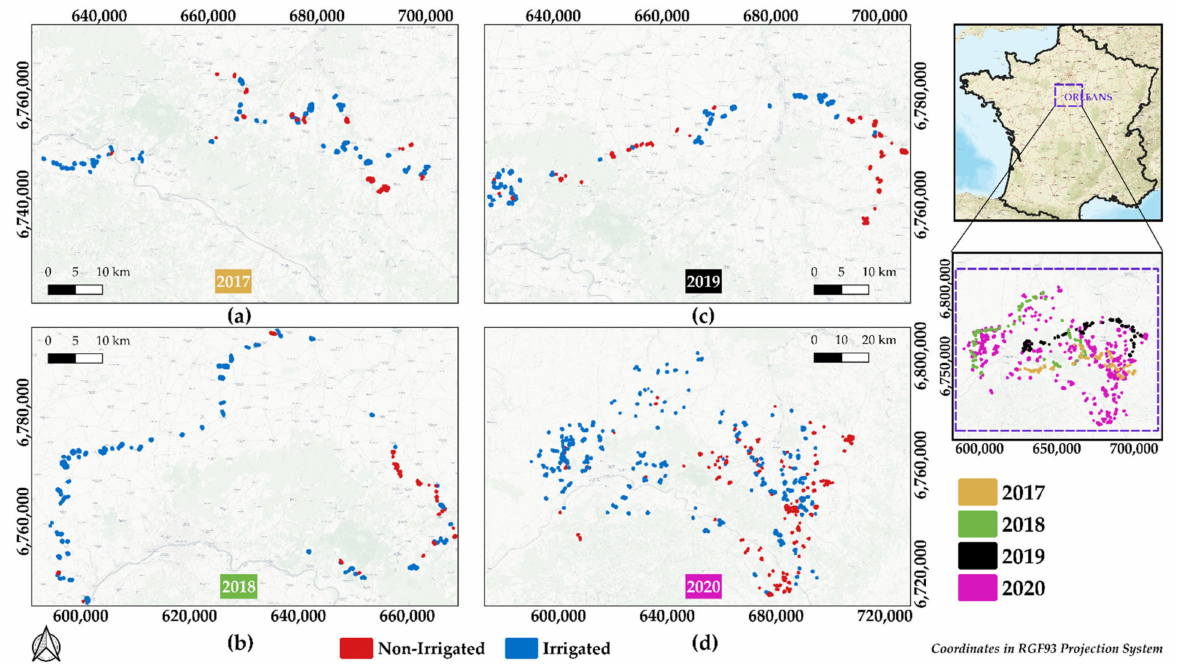
Figure 1. Location of the study site with collected in situ data near Orl é ans city in north-central France for ( a ) 2017, ( b ) 2018, ( c ) 2019, and ( d ) 2020. Non-irrigated plots are presented in red and irrigated plots are presented in blue.